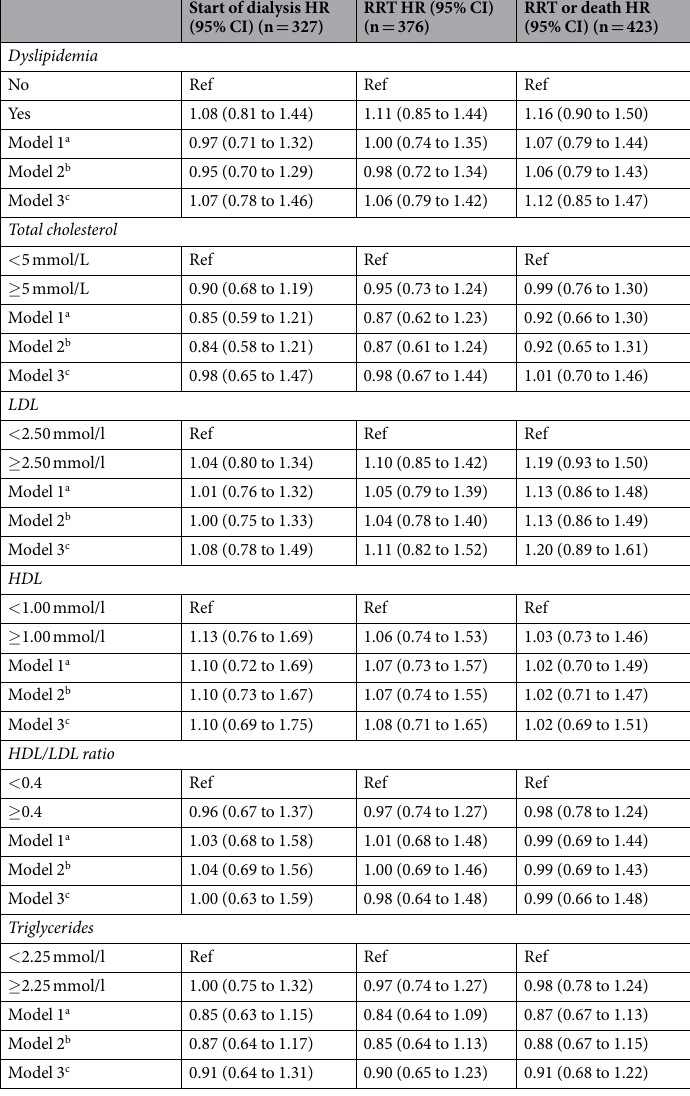
Table 3. Crude and adjusted hazard ratio (95% CI) according to the presence of dyslipidemia, serum lipids or triglycerides category for start of dialysis, RRT and combined endpoint (n = 502). a Model 1 was adjusted for; age, sex, ethnicity, current smoker, body mass index, diabetes mellitus, hypertension, proteinuria and primary kidney disease. b Model 2 was adjusted for: model 1 + CRP, Albumin, Subjective Global Assessment. c Model 3 was adjusted for: model 2 + Lipid-lowering medication use. CI: confidence interval, n: number, RRT: Renal Replacement